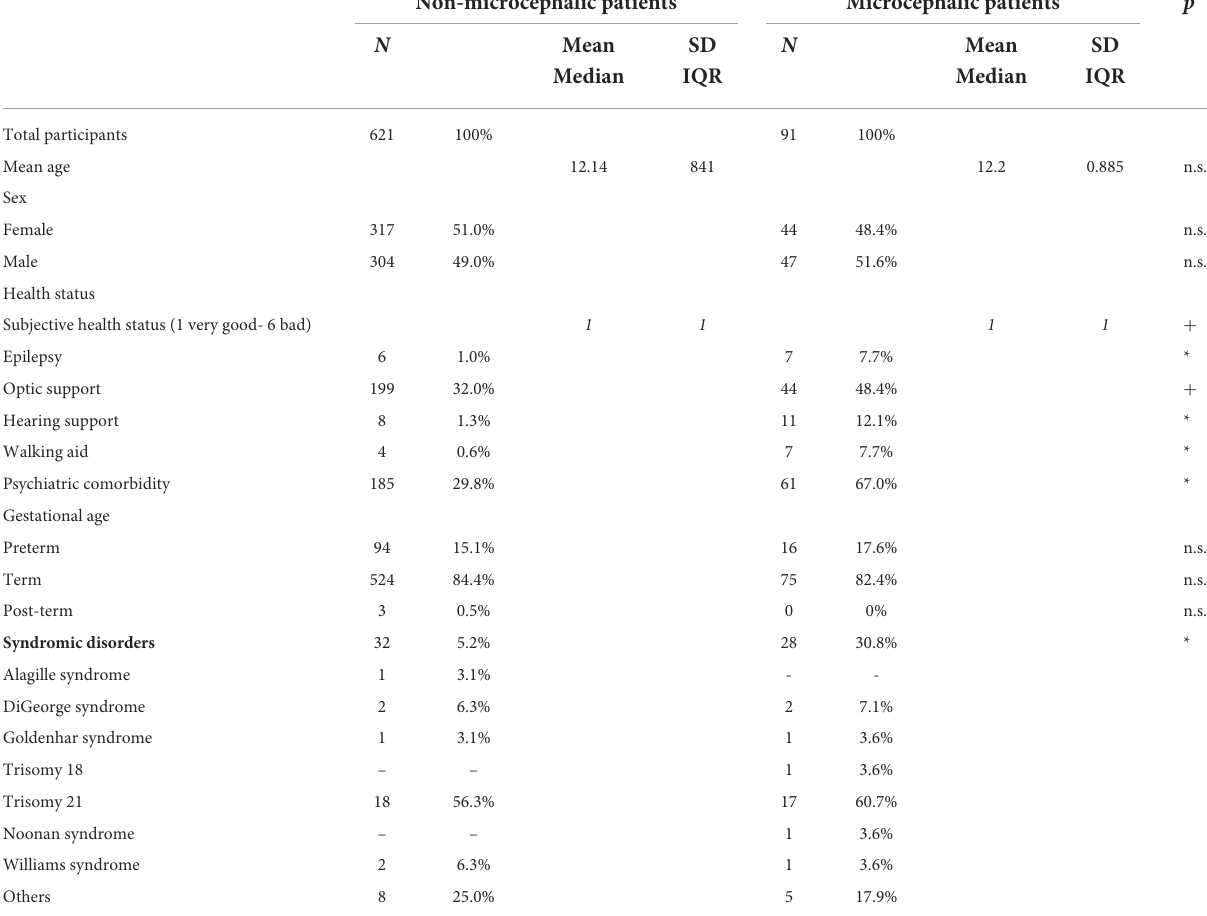
TABLE 3 Characteristics of microcephalic and non- microcephalic patients.